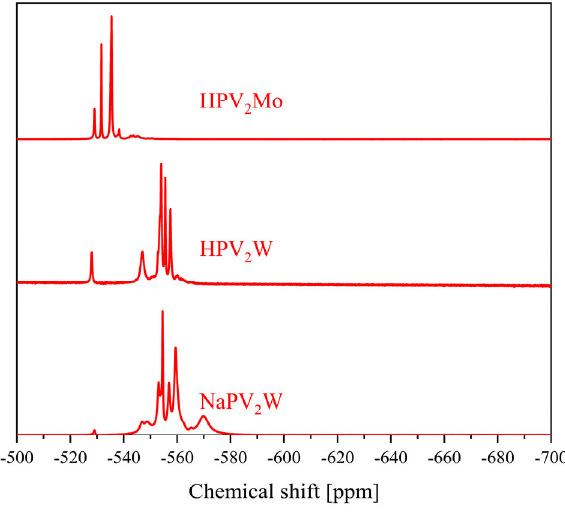
Figure 9. 51 V-NMR spectra of the POMs NaPV 2 W, HPV 2 W, and HPV 2 Mo. Spectra for NaPV 2 W and HPV 2 W were measured in a mixture of 70% water (pH 1) and 30% D 2 O, and spectra for HPV 2 Mo were measured in a mixture of 90% water (pH 1) and 10% acetone ‐ d 6. Measurement frequency: 157.8 MHz; NaVO 3 was used as an external standard.